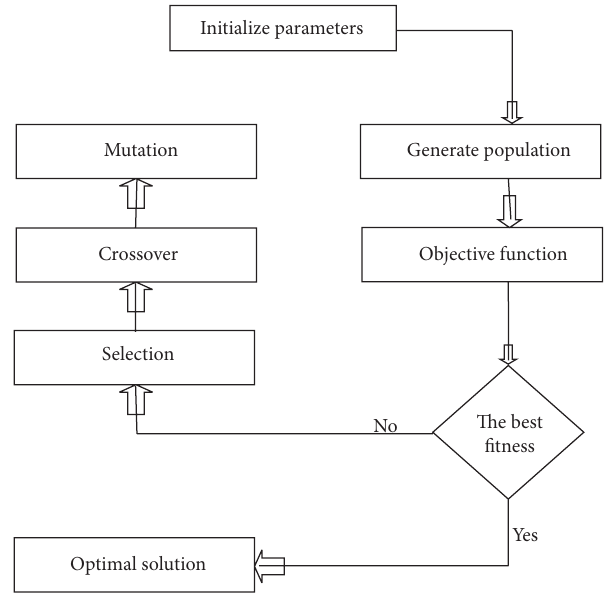
Figure 8: Traditional Genetic Algorithm.